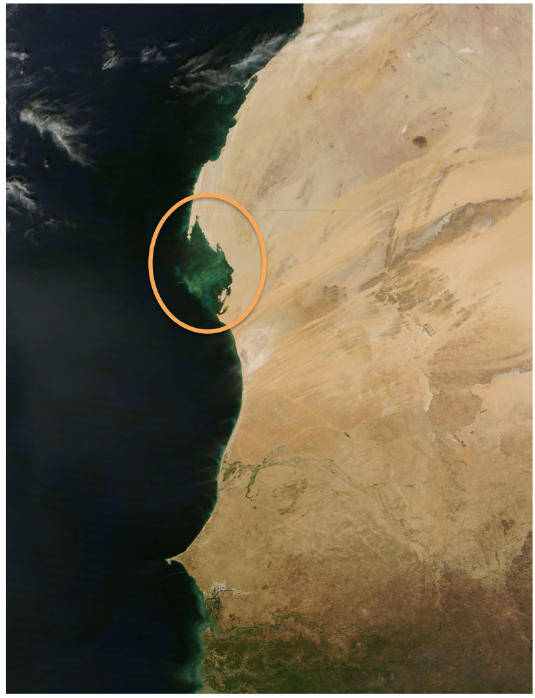
Fig. 6. MODIS picture of the west Mauritanian coast, 2006. Note: the circled area indicates the Banc d’Arguin